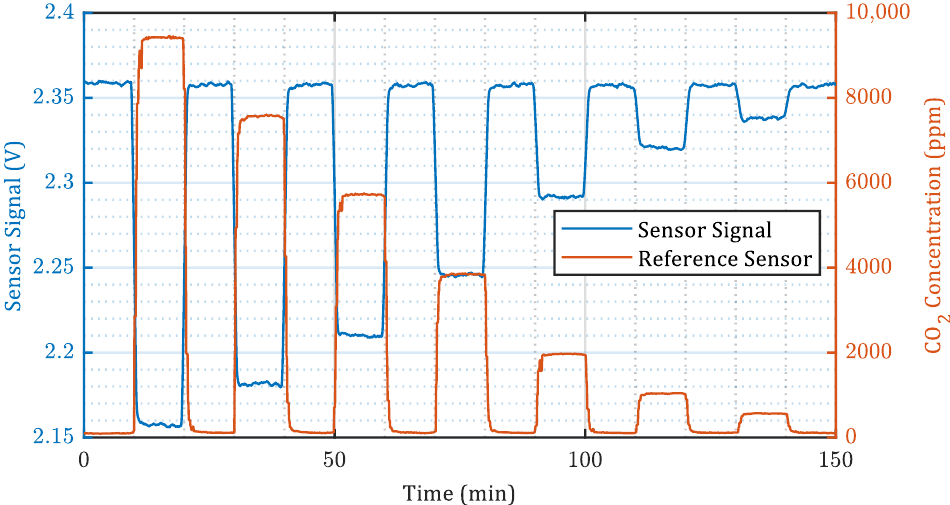
Figure 5. Measurement with an absorption distance of d = 15.5 mm showing 10 min steps with decreasing CO 2 concentration together with the output of a NDIR reference sensor (12-times moving mean filter applied).